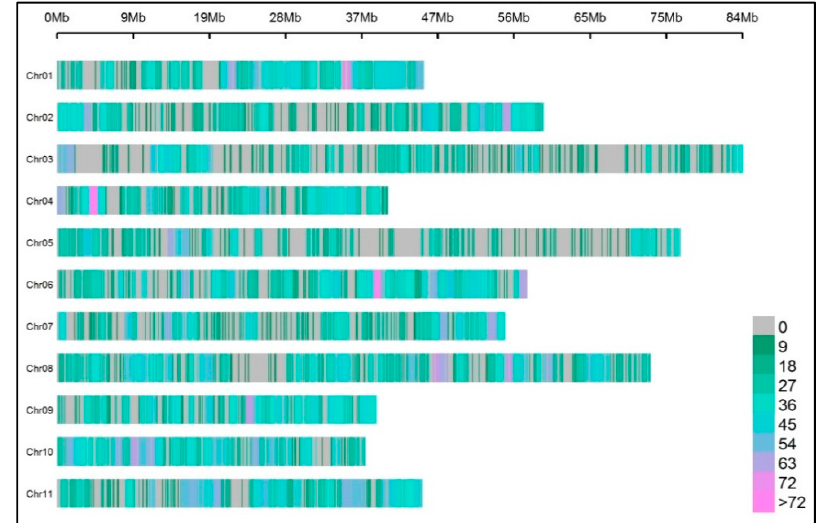
Figure 5. Distribution of 15,950 SNPs in the 11 chromosomes of E. grandis reference genome, NextSeq 24-plex run (1 Mb window).